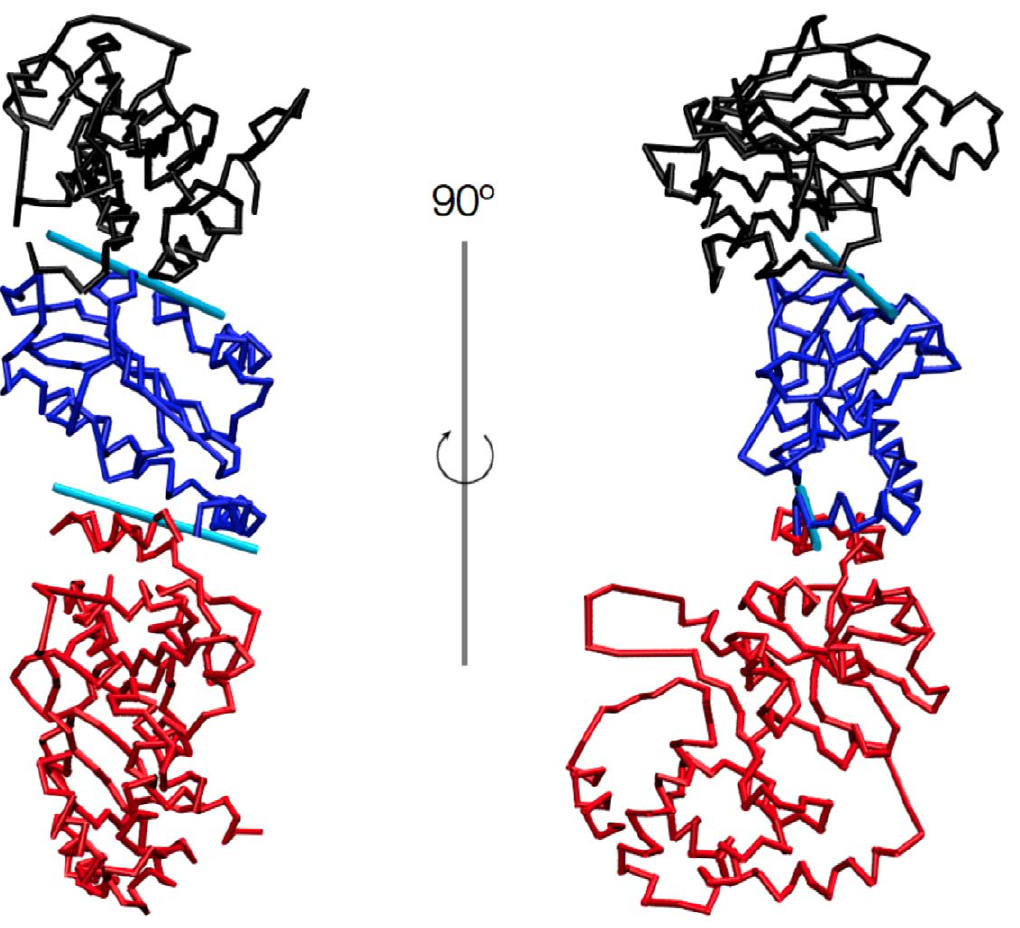
Figure 6. Fitting of the meta-trajectory with only rigid-body movements. Two orthogonal views of the template protomer used to fit all configurations of the Grp94, Hsp90 and HtpG meta-trajectory using only rigid-body movements of the two-terminal quasi rigid domains (black for N- term and red for C-term) respect to the middle (blue) one. The protomer is 525 amino acids long and is the structure closest to the average configuration of the full meta-trajectory. The optimal rotation axes are shown as cyan cylinders. The position and orientation of these axes are identified with an iterative procedure to allow the N-term and the C-term domains to perform those movements which best fit, on average, all frames in the meta-trajectory (see also Figure 7 for further details). It is worth noting that the axes are not forced a priori to pass through one of the two boundary residues at the interface between two domains.